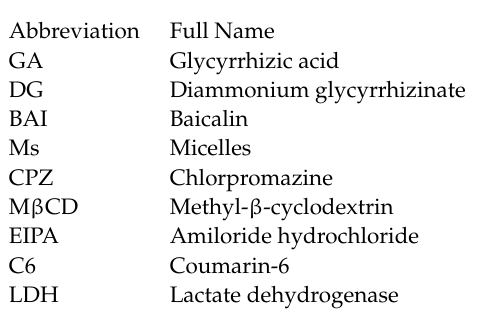
Figure S1: Evolution of the solvent accessible surface area (SASA) with time; Table S2: Elution gradient for HPLC; Figure S2: Transmembrane resistance of the Caco-2 cell monolayer; Table S3: Dosing concentration; Figure S3: Viability of Caco-2 cells treated with BAI, DG Ms, and BAI-DG Ms.; Section S1: Morphological observation methods of micelles by TEM and FESEM; Section S2: Molecular dynamics simulation methods; Section S3: HPLC method; Section S4: Preparation method of simulated gastric fluid (SGF) and simulated intestinal fluid (SIF); Section S5: Caco-2 cell assay; Section S5.1: Cell culture; Section S5.2: Preparation method of Coumarin-6 (C6)-labeled DG